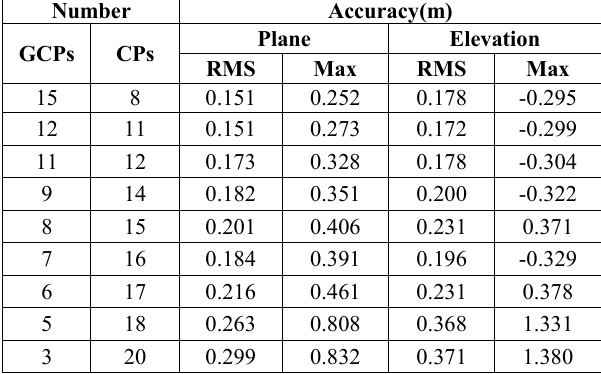
Figure 5 Orthophoto of experimental area Multi-images block adjustment experiment was carried out with different layout scheme of GCPs. The positioning accuracy was evaluated using CPs (Check Points), the results using the different number of GCPs are shown Table 4. In light of the requirement of 1:2,000 3D mapping specification, the plane accuracy is up to 1.75 m and elevation accuracy is up to 1m. achieve multi-images block adjustment, as shown in Table 4. Table 4. Accuracy elevation with the layout scheme of